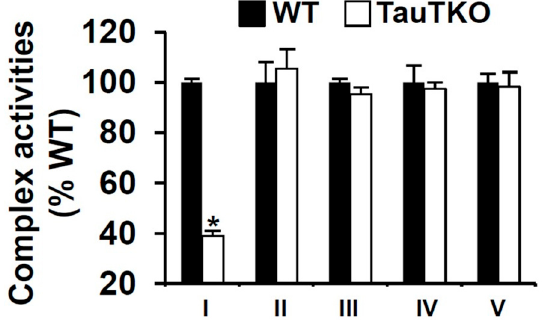
Figure 3. Taurine depletion decreases complex I activity. Isolated mitochondrial fractions of WT and TauTKO hearts were assayed for the activities of complexes I–V. Values of individual complexes shown represent means ± SEM of 4–6 different hearts. * p < 0.05.